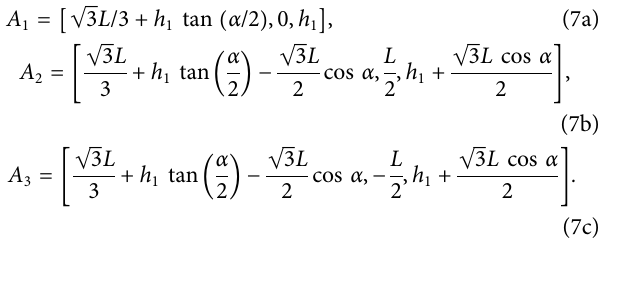
Frontiers in Robotics and AI |